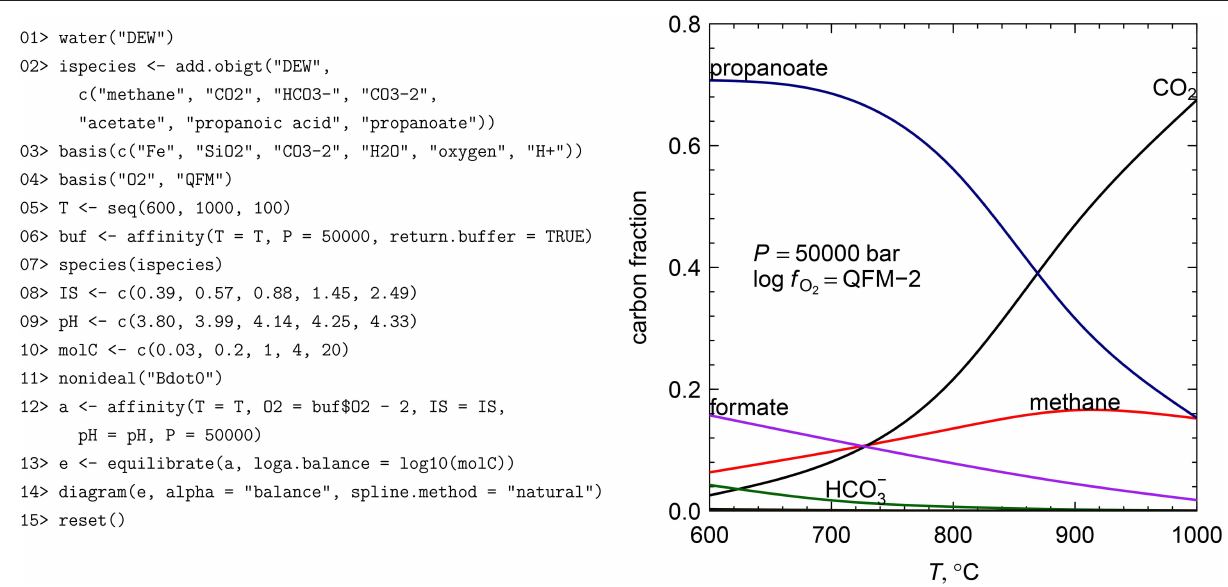
transect, and varying the concentration of the conserved basis species along the